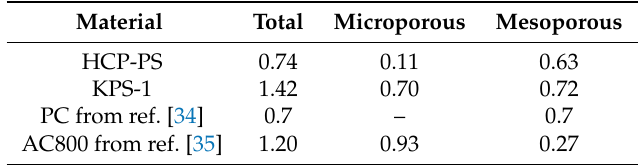
Table 1. Porous volume (cm 3 /g) of the produced